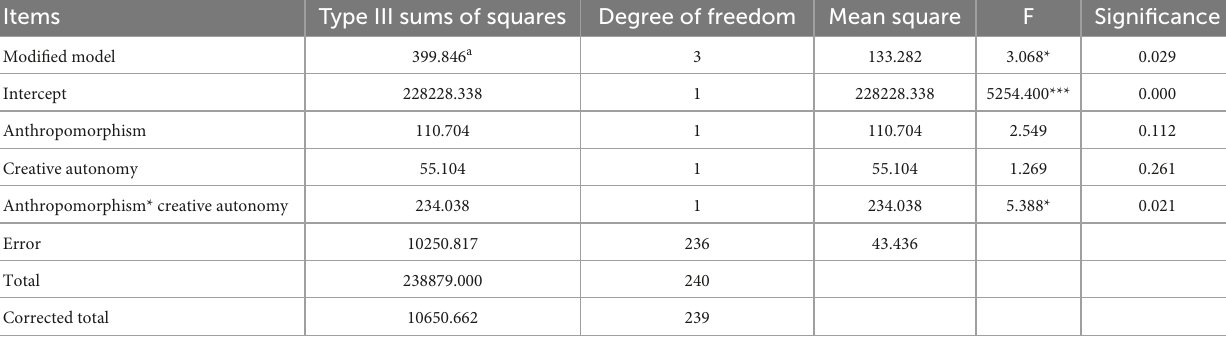
TABLE 2 Test of the effect of anthropomorphism and creative autonomy on the rating of painting.